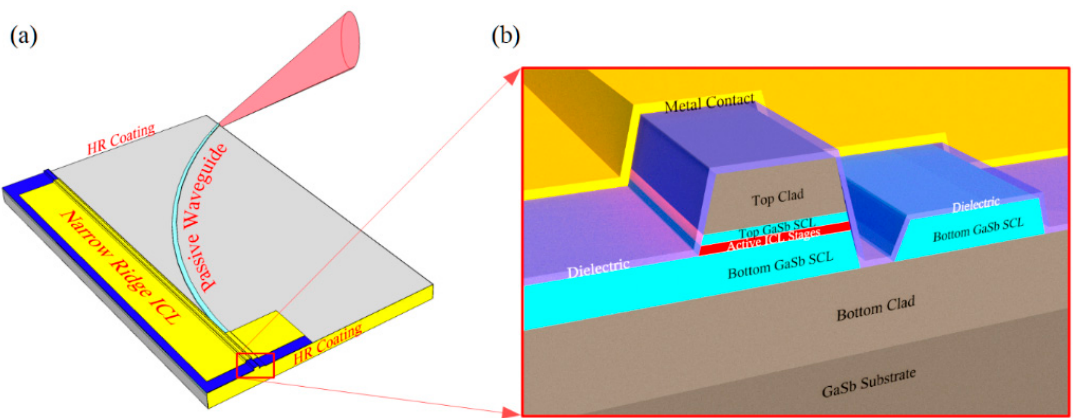
Figure 7. ( a ) Schematic showing light extraction from a laser cavity via evanescent coupling to a passive waveguide that runs parallel to a section of the active gain waveguide; ( b ) detailed cross-section of the two waveguides at the HR-coated facet.